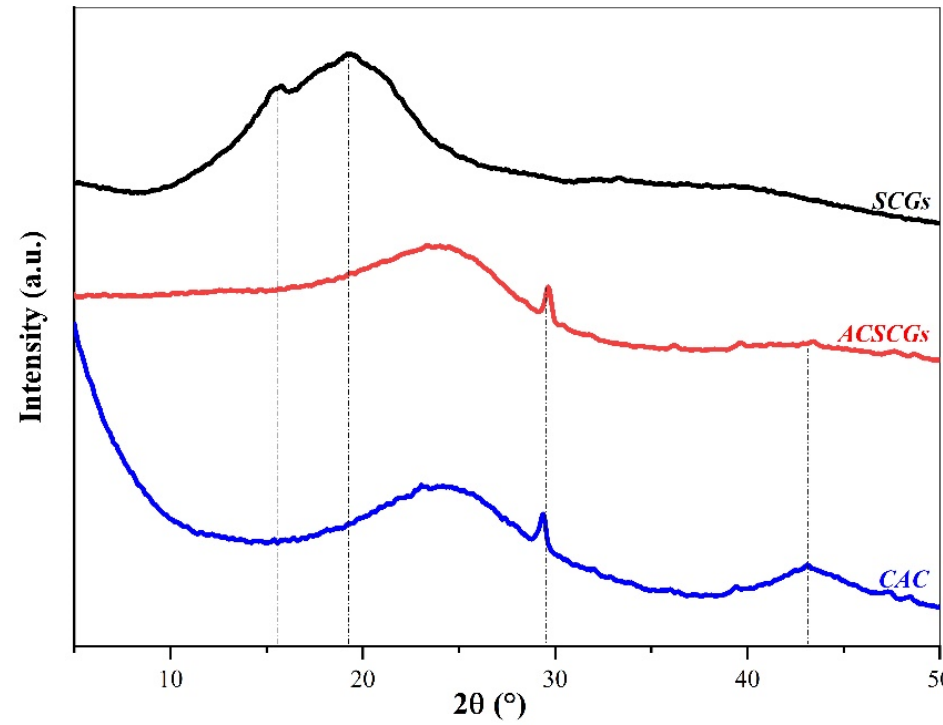
Figure 2. XRD spectra of SCGs, ACSCGs and CAC.